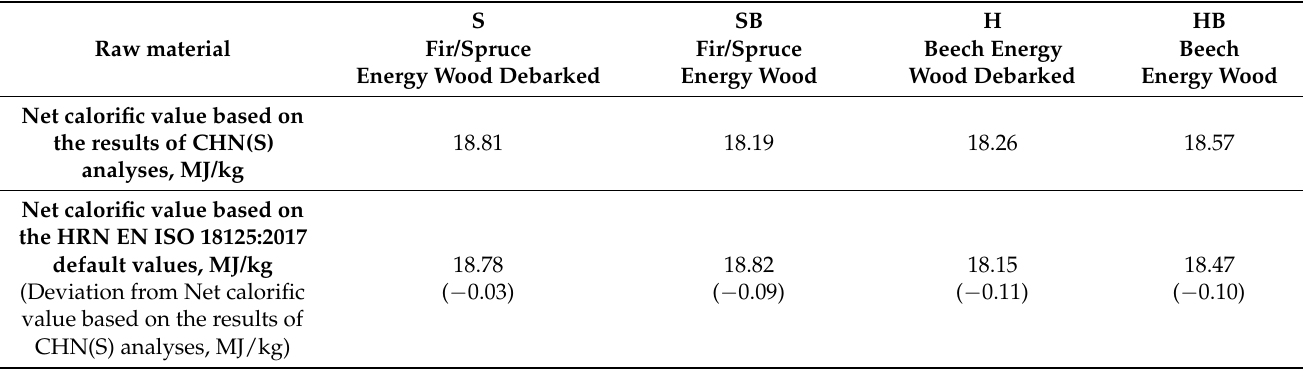
Table 4. Results of the net calorific value calculation.